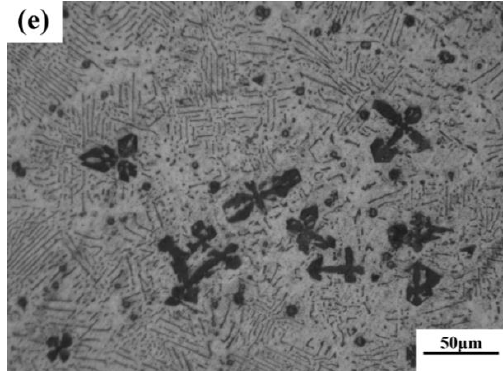
Figure 3. Optical microstructure of as-cast Mg – Si binary alloy. ( a ) Mg – 1 wt.% Si; ( b ) Mg – 1.38 wt.% Si; ( c ) Mg – 2 wt.% Si ( d ) Mg – 3 wt.% Si; ( e ) Mg – 4 wt.% Si.